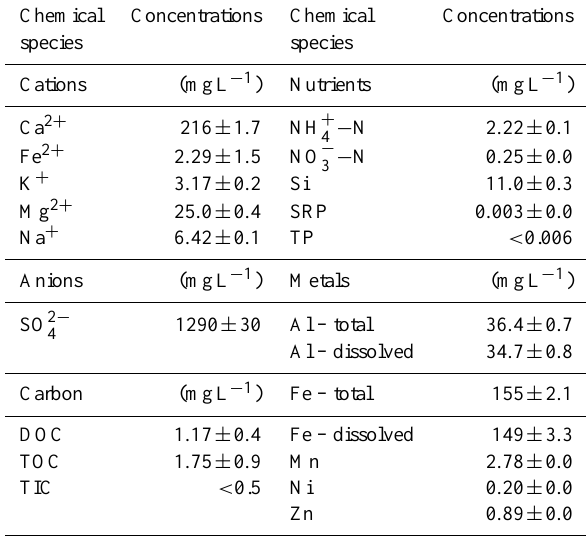
Table 1. Chemical characteristics of the water of the Mining Lake 111, July 2008 ( N = 4). Means ± SD of samples corresponding to different water depth (0, 1.5, 4, 6m). DOC = dissolved organic carbon; TOC = total organic carbon; TIC = total inorganic carbon; DIN = dissolved inorganic nitrogen; SRP = soluble reactive phos- phorus; TP = total